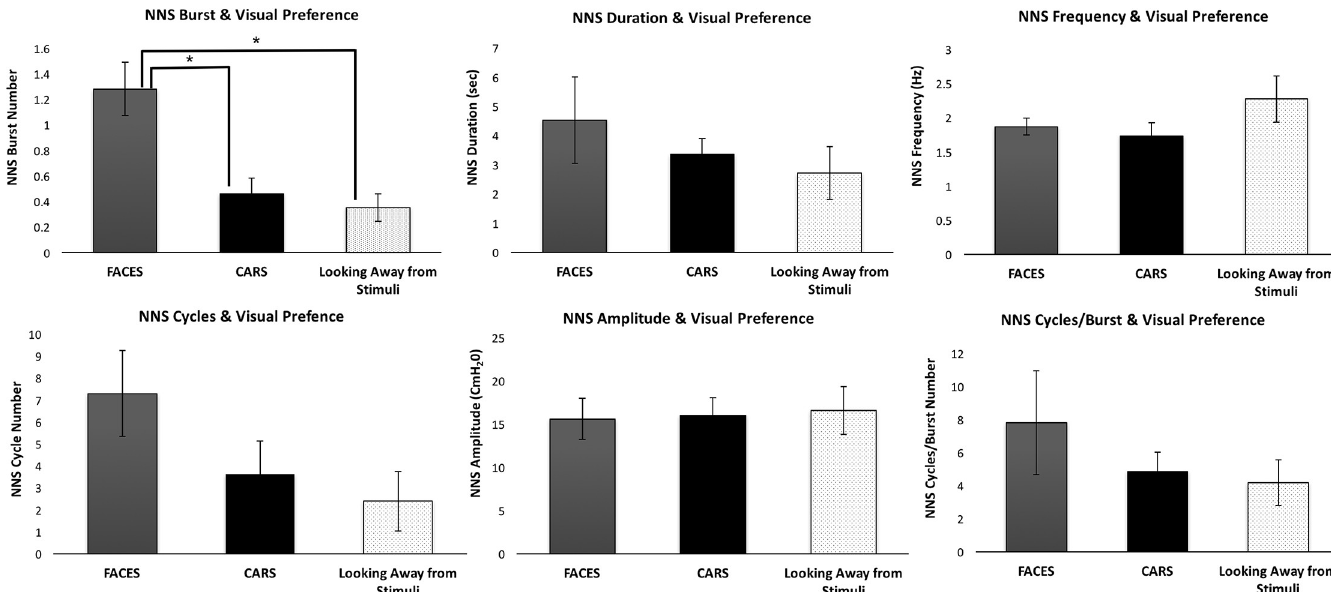
Fig 3. Non-nutritive suck and visual preference. The non-nutritive suck variables are compared during FACES (gray), CARS (black) and looking away from stimuli (dotted bar) across the four (30s) trials. Error bars represent the standard errors of the mean (SEM). � : p < 0.05.